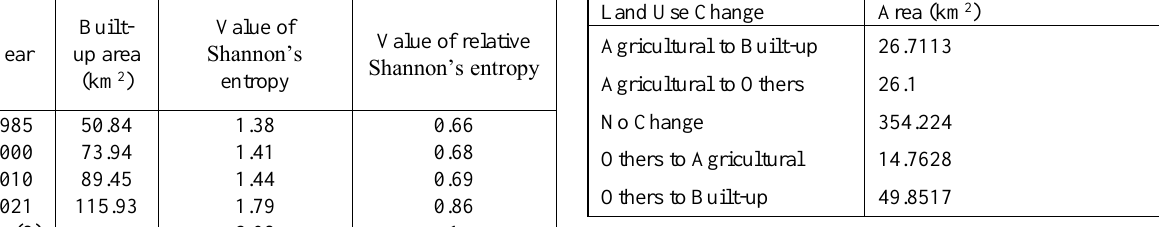
Table 6 . Land use Change in Qom, Iran from 1985 to 2021